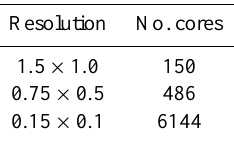
Figure 19. Efficiency up to 486 cores. A resolution of 2 . 25 × 1 . 51 ◦ was used to examine the limit of the parallelization performances for 2-D advection. For this test, the Airain cluster was used, which has 9504 nodes where each node has an Intel Xeon processor (16 cores, 2.7GHz and 4GB of shared memory). Table 4. Estimation of the number of cores needed for an efficiency of 0 . 75 for 2-D advection at several resolutions (lat × long).